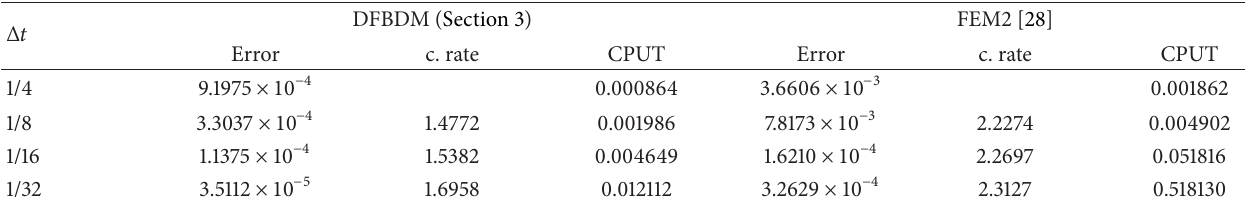
Table 6: Comparison of error, convergence rate, and CPUT for (47) with 𝛼 = 0.5 and 𝛽 = 0.3